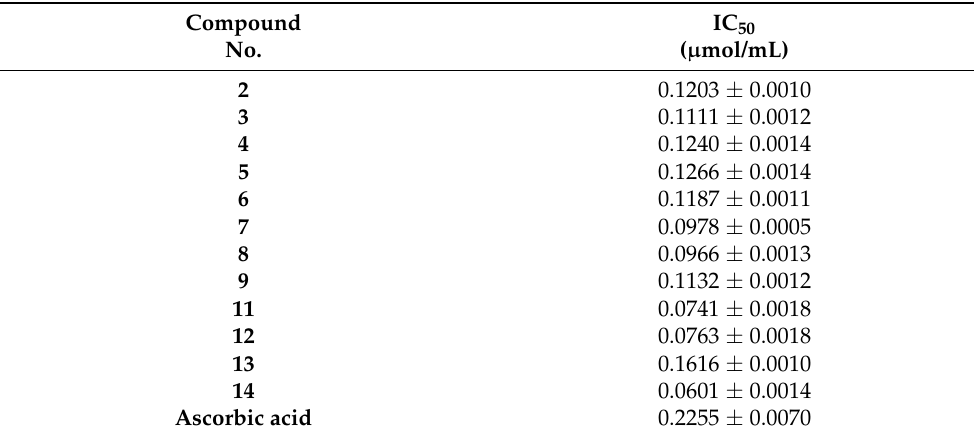
Table 3. The IC 50 of the compounds 2–14 and the standard antioxidant in the DPPH